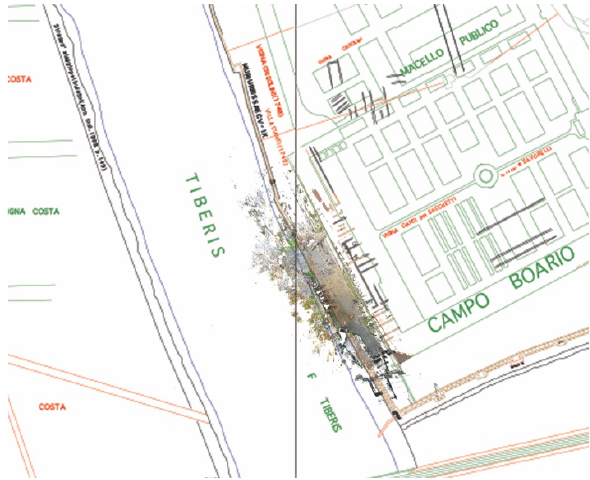
Figure 13. Overlap of the point cloud obtained by laser scanning, with the plan of the Forma Urbis of Rodolfo Lanciani This work of data processing and reconstruction of the geometries and fabrics of part of the city of Rome is part of a wider research aimed at reconstructing the ancient aspect of the